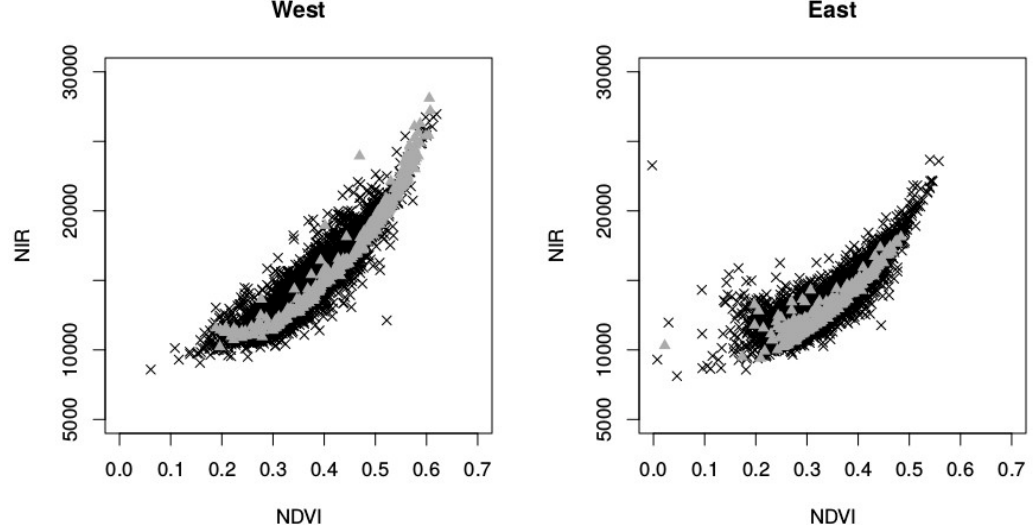
Figure 4. Scatter plots of NDVI and NIR values of random samples representing the variation of the inventory areas (black crosses) and the final sample (gray triangles) in the west and east banks of the river.